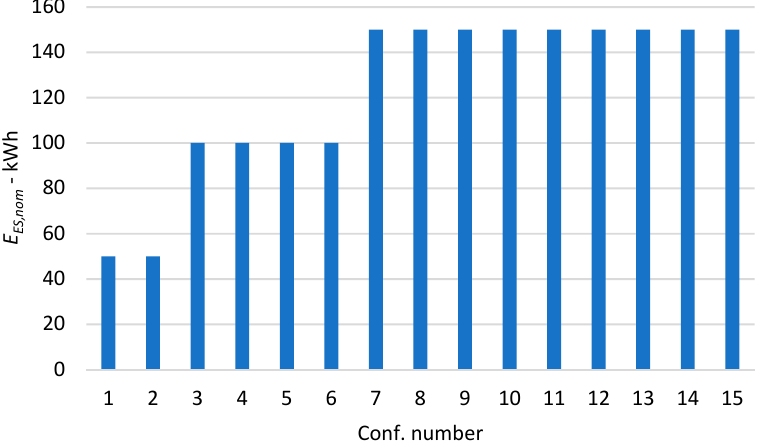
Figure 5. Nominal electrochemical storage ( ES ) energy for the configurations on the Pareto Frontier.